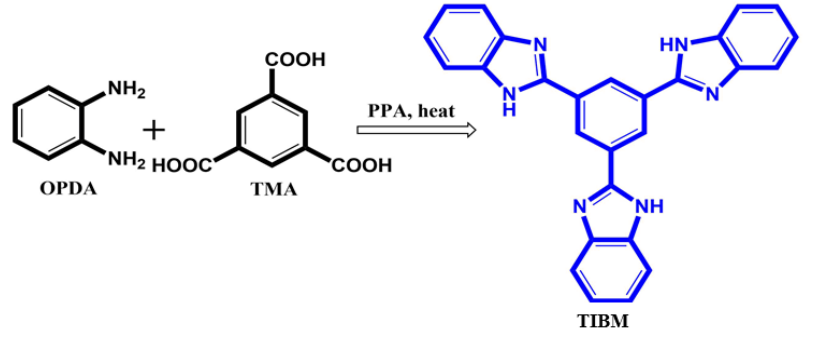
Figure 9. Synthesis of TIBM linker.